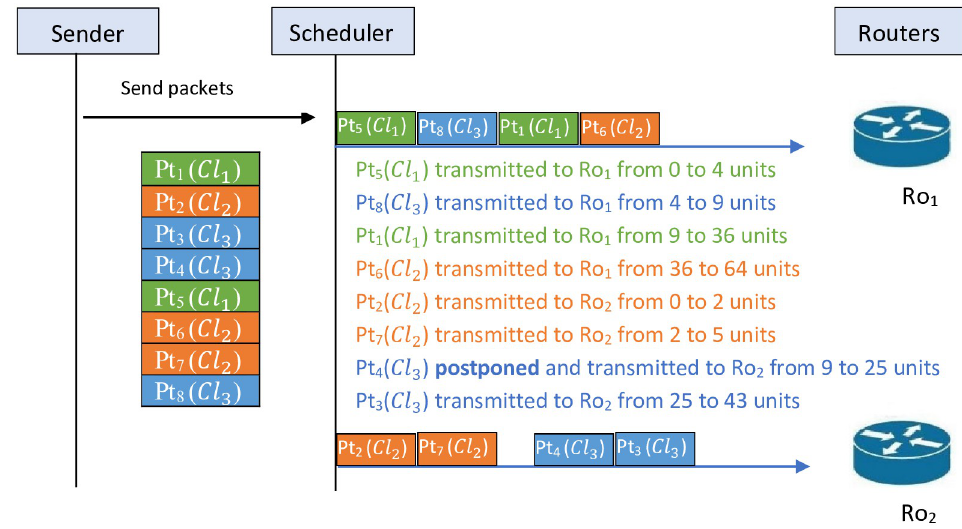
Fig 8. Schedule of STF